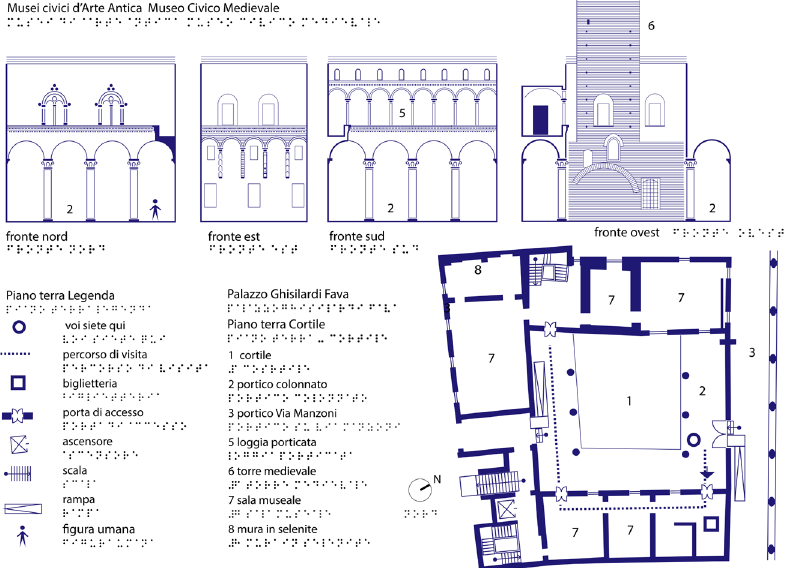
FIG. 4 Orientation and mobility tactile map design for the Medieval Museum of Bologna